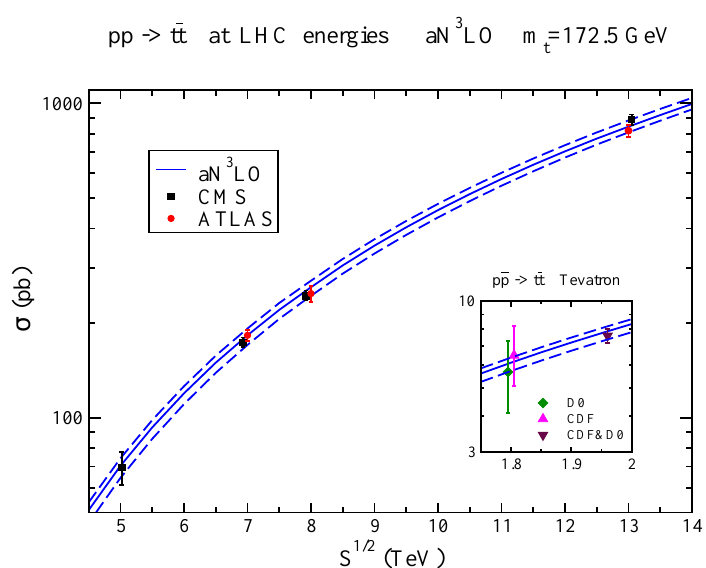
Figure 4. Top-antitop aN 3 LO cross sections compared with CMS data at 5.02 TeV [38] and with ATLAS and CMS data at 7 TeV [39,40], 8 TeV [40,41], and 13 TeV [42,43] LHC energies. The inset shows the aN 3 LO cross section compared with CDF [44] and D0 [45] data at 1.8 TeV, and CDF&D0 combined data [46] at 1.96 TeV Tevatron energy.